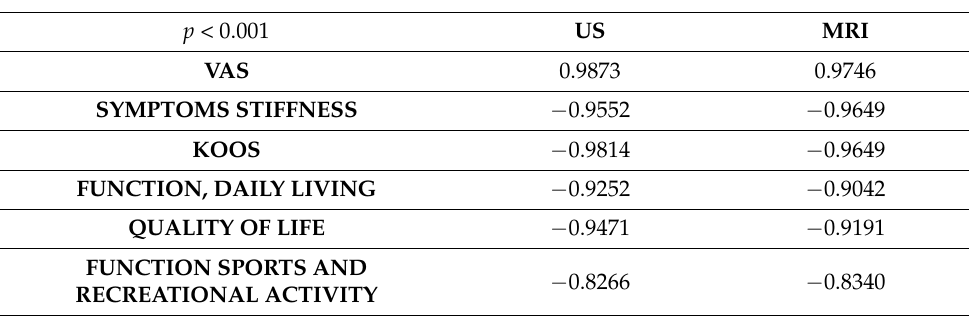
Table 7. Correlation Matrix to compare instrumental and clinical data. Correlation results of clinical and instrumental parameters showing high direct or inverse correlation. A correlation between medial condyle distance measured with MRI and US and the VAS scale is direct and equal to 99% (0.9873), statistically significant ( p < 0.001). The correlation between medial condyle distance measured with MRI and US and the KOOS score is inverse and equal to 98% ( − 0.9814), statistically significant ( p < 0.001). MEDIAL PATELLO-FEMORAL DISTANCE p < 0.001 US MRI VAS 0.9873 0.9746 SYMPTOMS STIFFNESS − 0.9552 − 0.9649 KOOS − 0.9814 − 0.9649 FUNCTION, DAILY LIVING − 0.9252 − 0.9042 QUALITY OF LIFE − 0.9471 − 0.9191 FUNCTION SPORTS